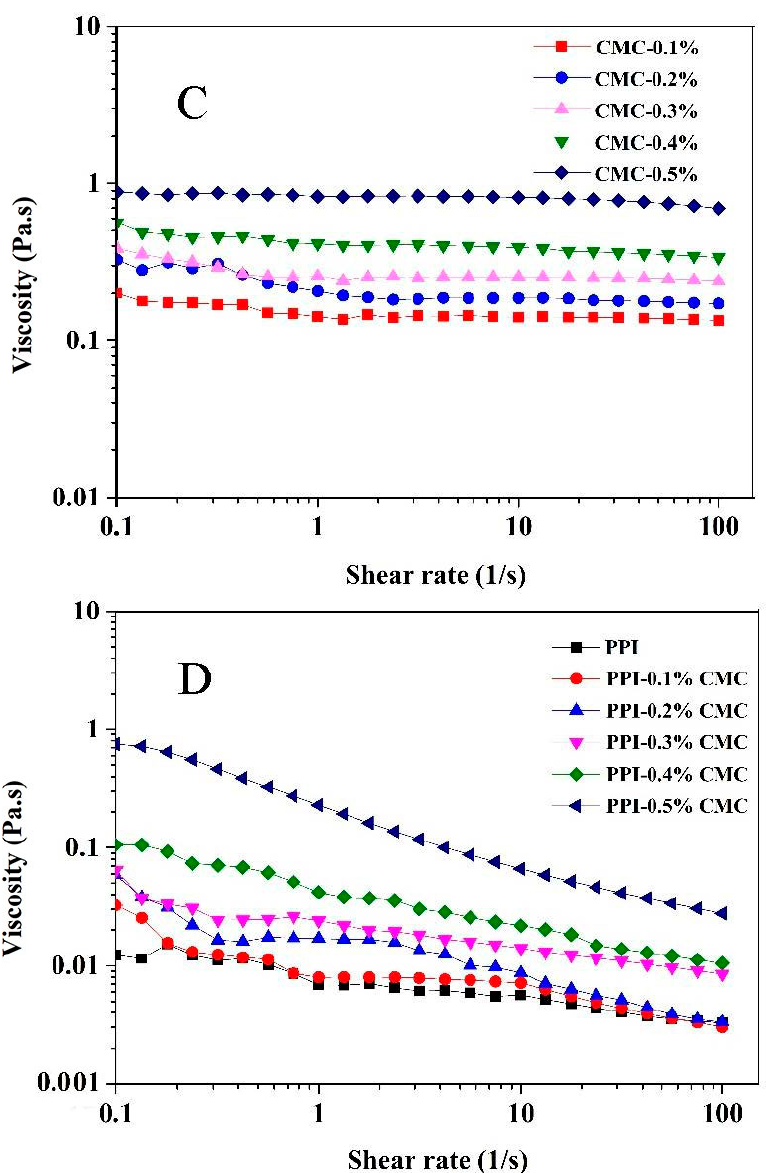
Figure 6. The changes of the viscosity with the shear rate of the individual CMC solution at pH 7.0 and pH 4.5 ( A , C ) and PPI-CMC mixed solutions at pH 7.0 and pH 4.5 ( B , D ). Table 1. K and n values for CMC and PPI/CMC mixed solutions at pH 7.0 and 4.5.